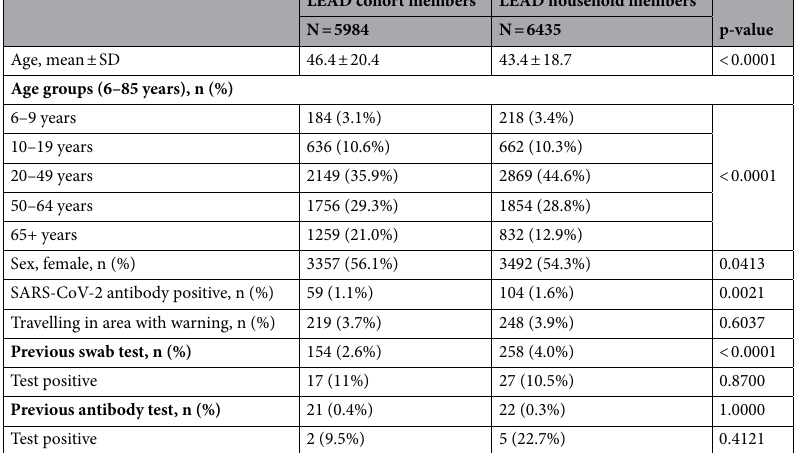
Table 1. Comparison of LEAD cohort members and household members.